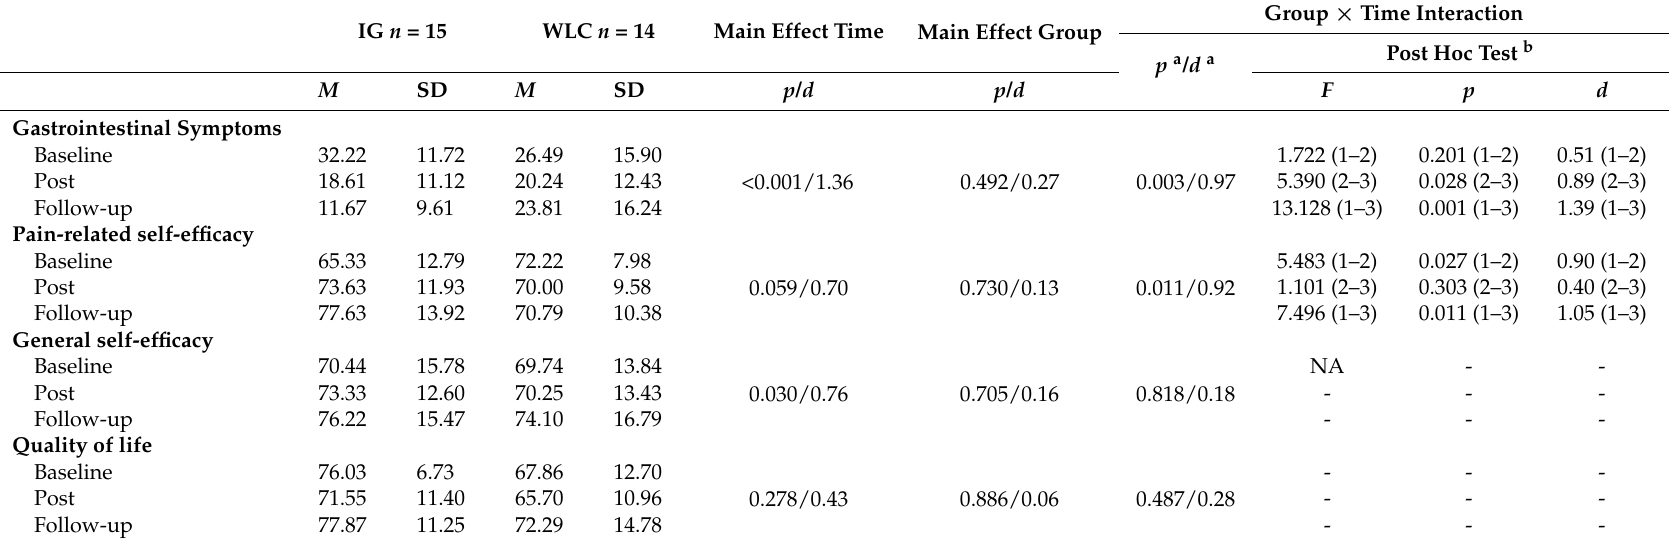
Table 2. Outcome measures (means, SDs ) with results of repeated measures ANOVA (main effects for group, time, and group × time interaction).